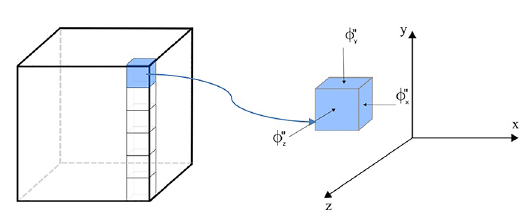
Figure 3. Control volume with mass flow conditions in x, y and z directions.